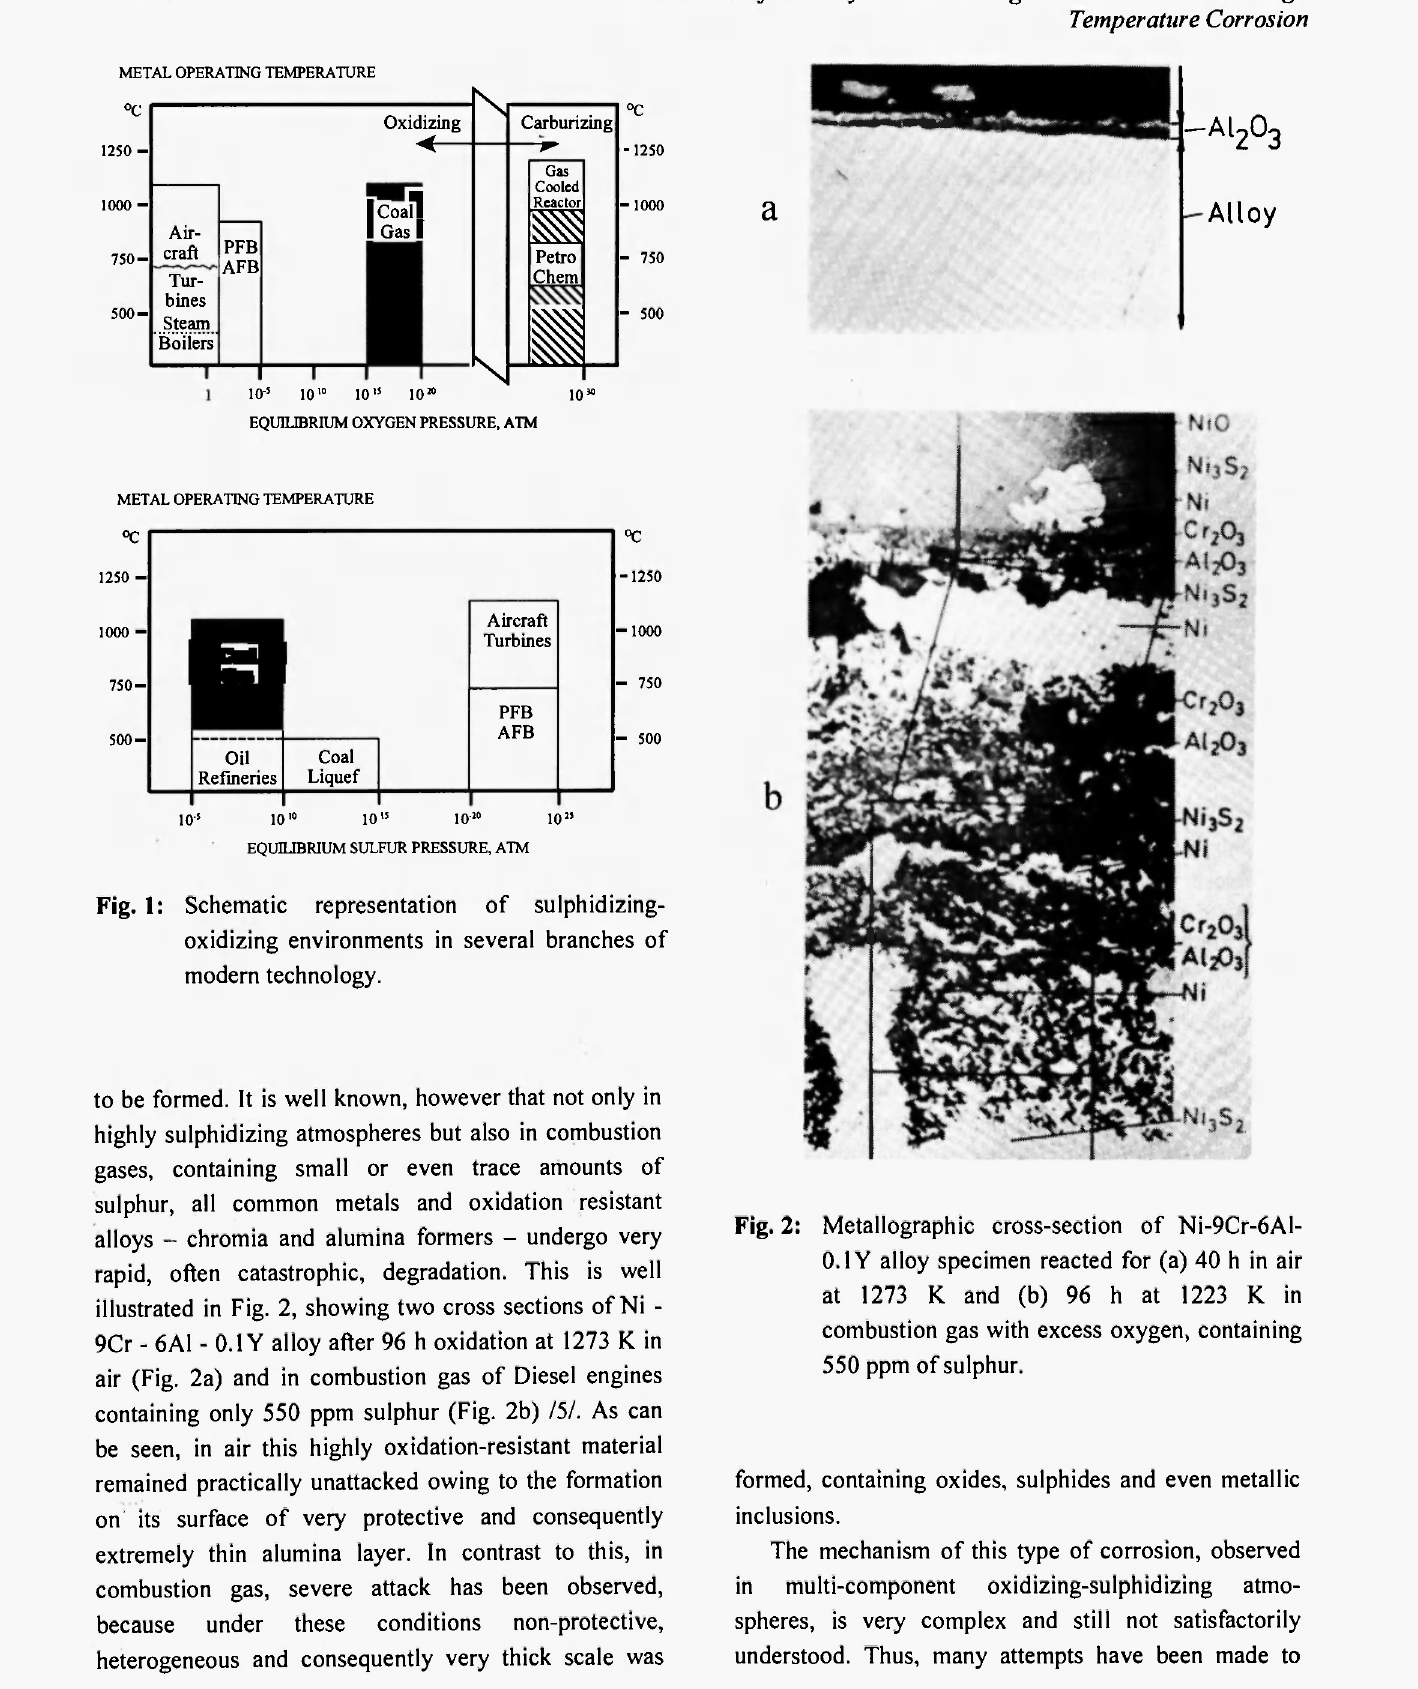
formed, containing oxides, sulphides and even metallic